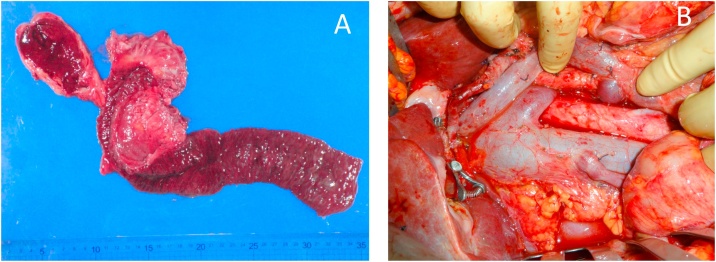
Surgical specimen of subtotal stomach preserving pancreaticoduodenectomy (A) and an intraoperative picture after dissection of para-aortic lymph nodes (B).